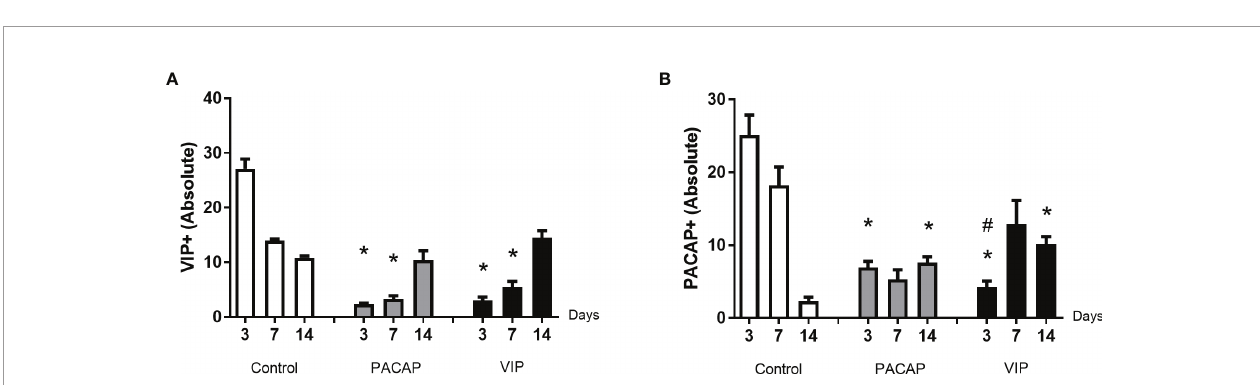
FIGURE 5 | Analysis of in fl ammatory cells in the alveolar bone healing kinetics after tooth extraction in control, VIP and PACAP treated mice. Immunohistochemistry quanti fi cation corresponding (A) F4/80 + , (B) CD80 + , (C) CD206 + , (D) Ly6g-Gr1 + , and (E) CD3 + (* represents the differences between the control